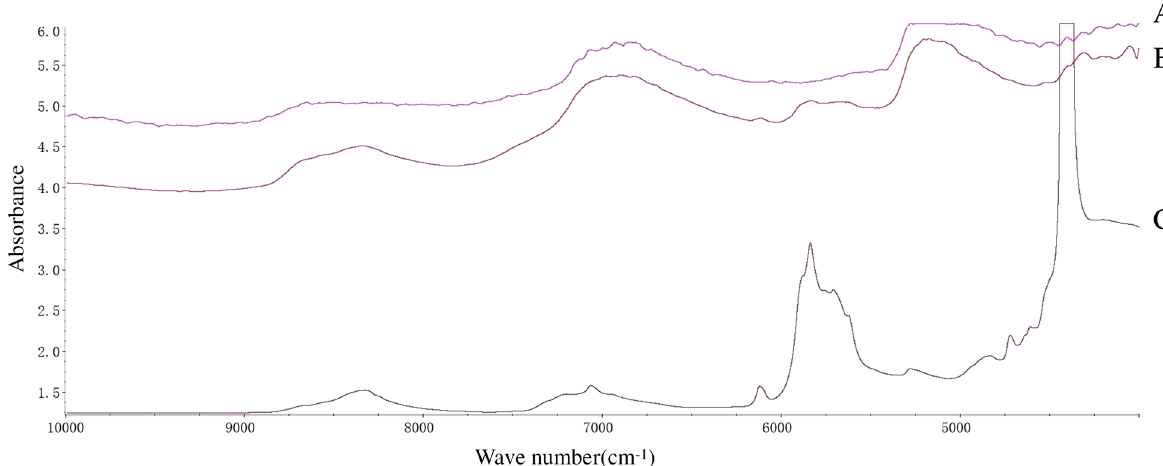
Fig. 2 Near‑infrared spectrogram. A Pearl powder suspension. B Pickering emulsion. C Calamus